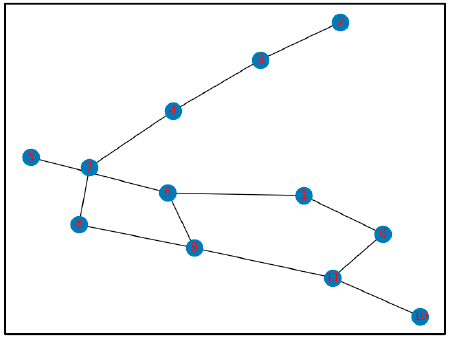
Figure 1. The social network. Table 1. The equilibrium resources received by each agent and expected utilities of firms.